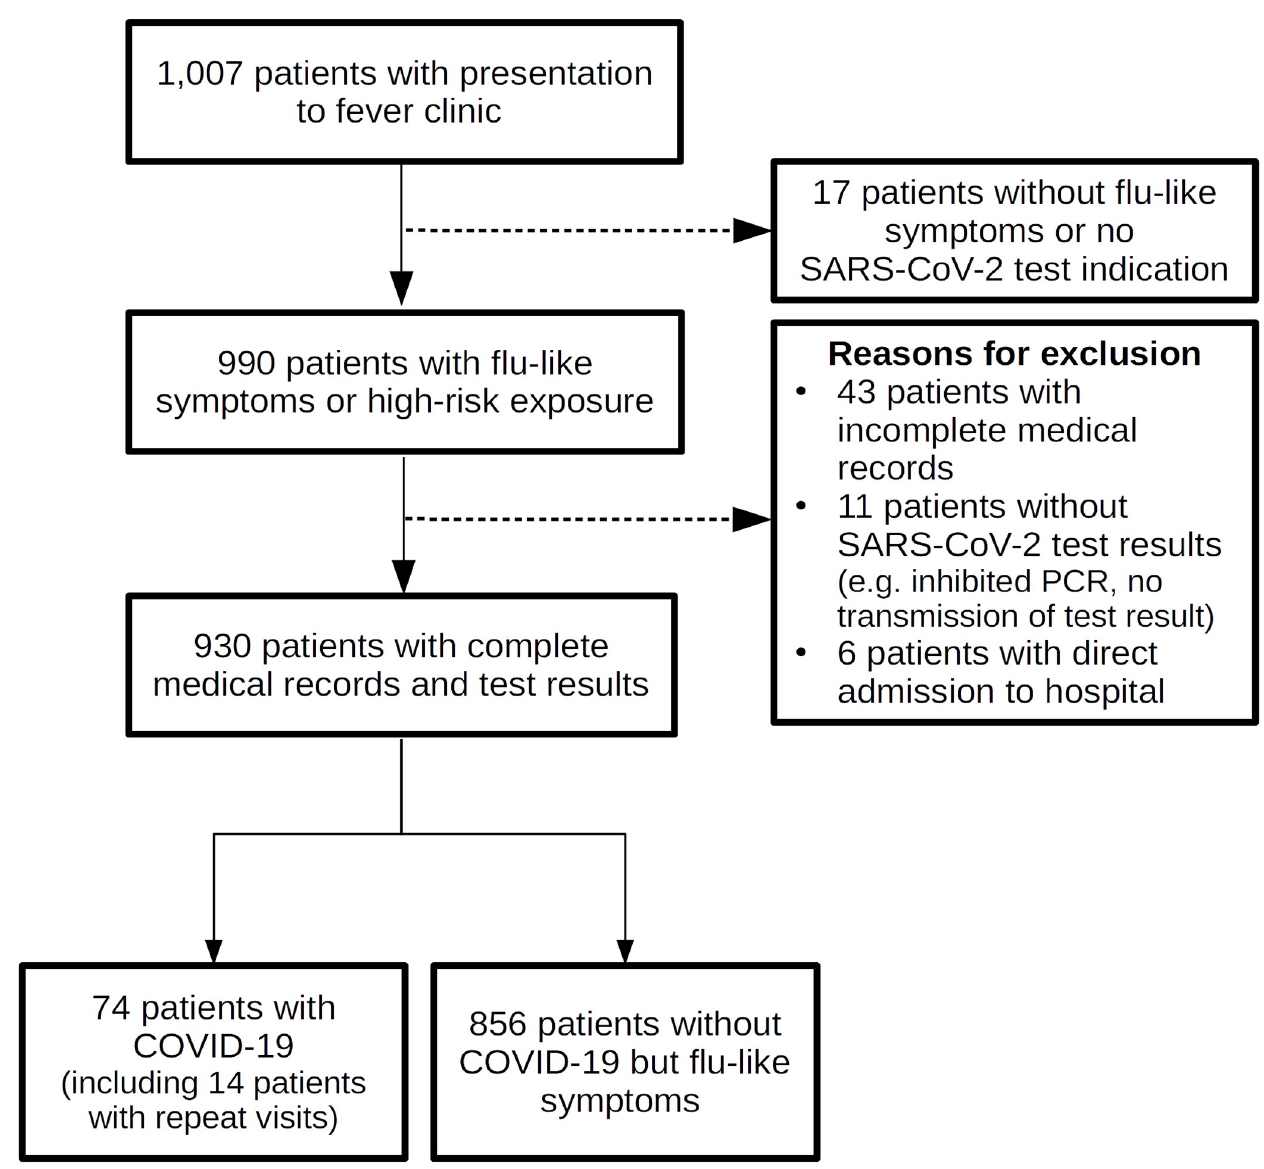
Fig 1. Flow diagram showing study population selection. All patients visiting a fever clinic from 4th of April 2020 to 15th of May 2020 with flu-like symptoms or high-risk exposure were included in this study. In case of repeated visits only data from the first visit was used.